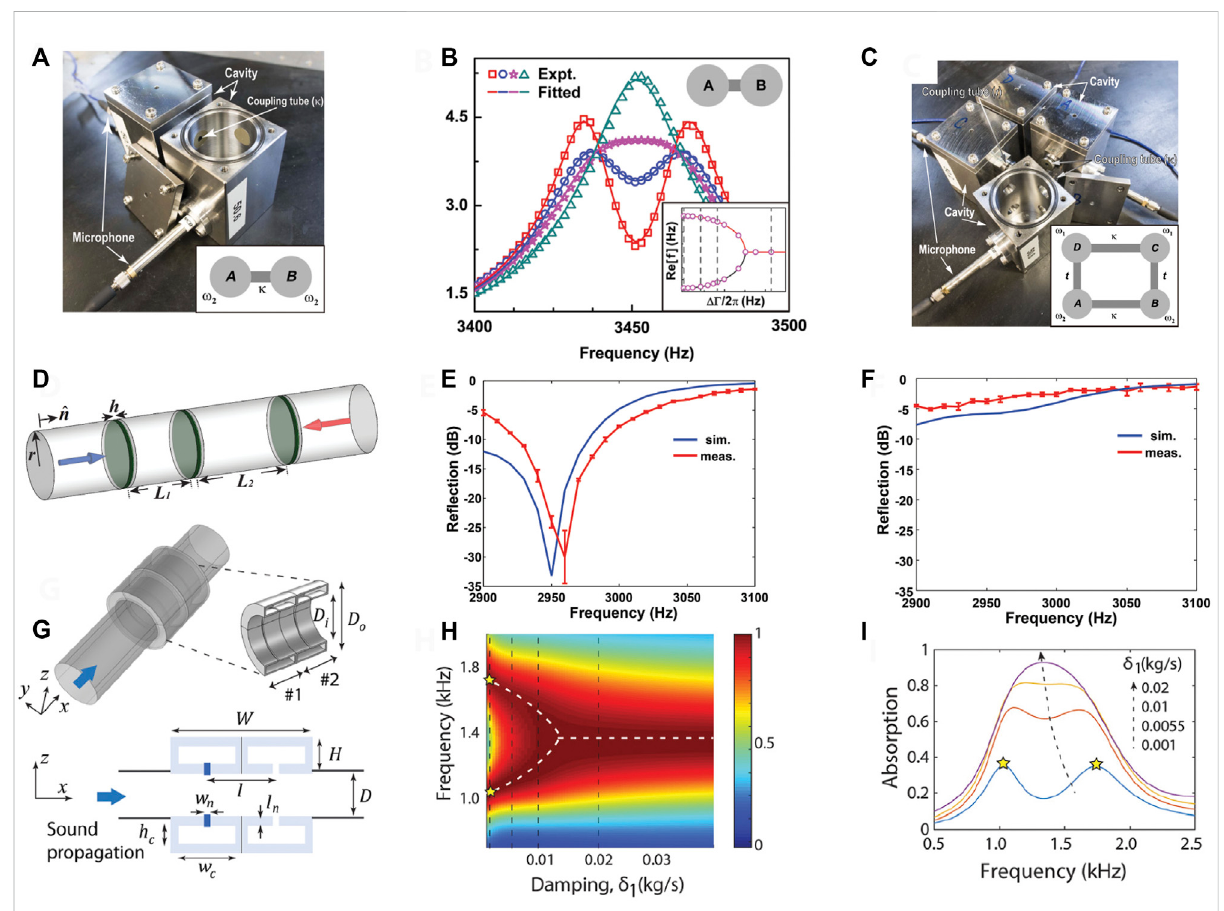
FIGURE 9 Exceptionalpointincoupledresonatorsystem. (A) Exceptionalpointoftwocavityresonatorsinaclosedsystem. (B) acousticspectraforvarying loss. (C) Higher-order exceptional point. (D) Exceptional point for unidirectional zero re fl ection. Re fl ection spectra from one incidence (E) and the opposite direction (F) . (G) EP-based duct silencer for perfect absorption. (H) Absorption spectra for different damping exhibiting absorption peak collapse. (I) Representative absorption spectra. Reprint (A – C) from Ref. [23]; (D – F) from Ref. [59]; (G – I) from Ref.